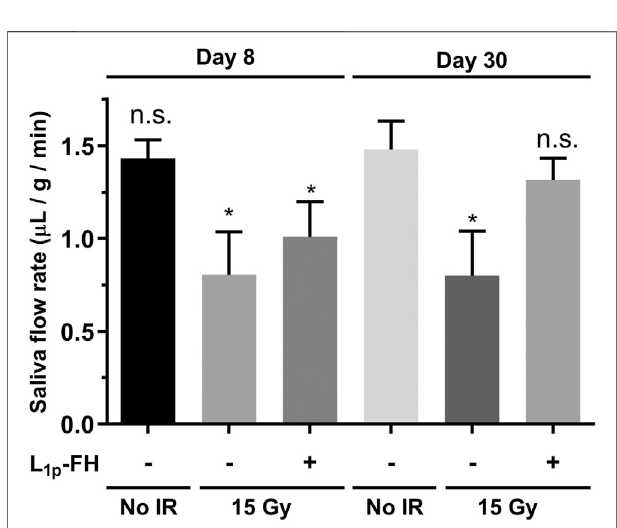
FIGURE 5 | L 1p -FH increases saliva secretion after radiation treatment. Mice were anesthetized and stimulated with pilocarpine and isoproterenol at days 8 and 30 with saliva collected for 5 min. Data represent the means ± SD of n (cid:1) 5 mice per condition with statistical signi fi cance assessed using one-way ANOVA (* p < 0.01) and Dunnett ’ s post-hoc test for multiple comparisons to group 1 (non-irradiated mice at day 30). The symbol (+) indicates L 1p -FH injection, while the symbol ( − ) indicates no L 1p -FH injection, and n. s indicates no signi fi cant differences from group 1 (non-irradiated mice at day